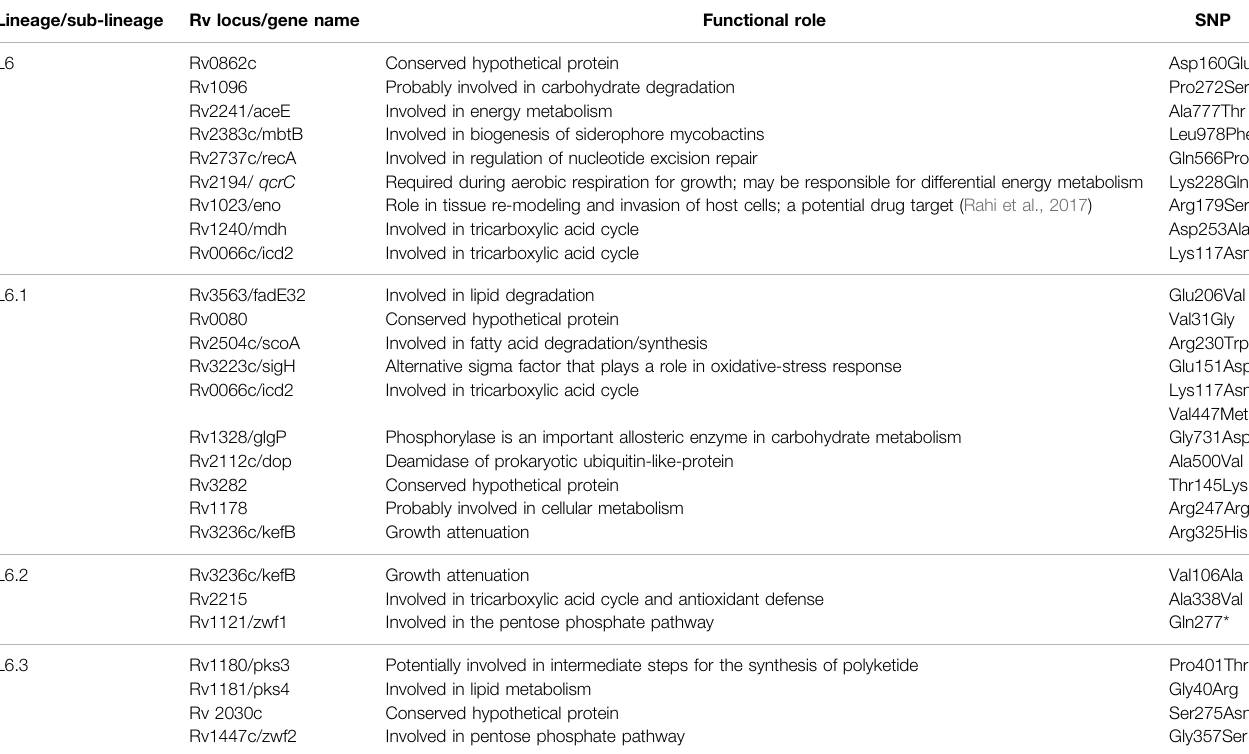
TABLE 4 | Functional mapping of core-cluster-speci fi c missense SNPs of L6 with literature support (Gehre et al., 2013; Ofori-Anyinam et al., 2017; Ofori-Anyinam et al., 2020) functional role obtained from Mycobrowser (url: https://mycobrowser.ep fl .ch/).